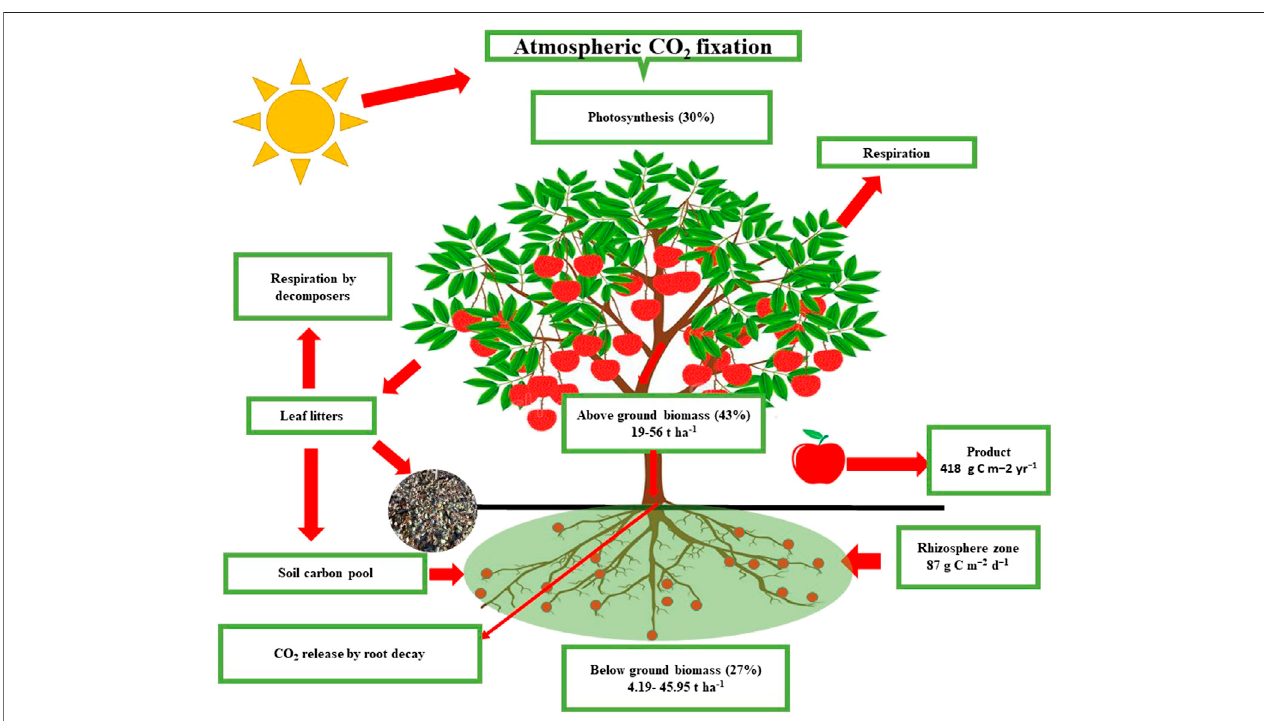
FIGURE 1 | Schematic diagram of carbon pools in an apple tree (redrawn from Buchmann and Schulze, 1999). The yearly NEP, GPP, and NPP are 403 g Cm − 2 , 1,346, and 906 g Cm − 2 year − 1 , respectively. The average NECB indicates signi fi cant potential for CO 2 sequestration. OM/OA: organic manures/organic amendment; GPP:grossprimaryproduction;NPP:netprimaryproduction;NEP:netecosystemproduction;NECB:netecosystemcarbonbalance;NBP:netbiomeproductivity;RA: autotropic respiration; RH: heterotrophic respiration; Harvest: fruit production; R ECO : ecosystem